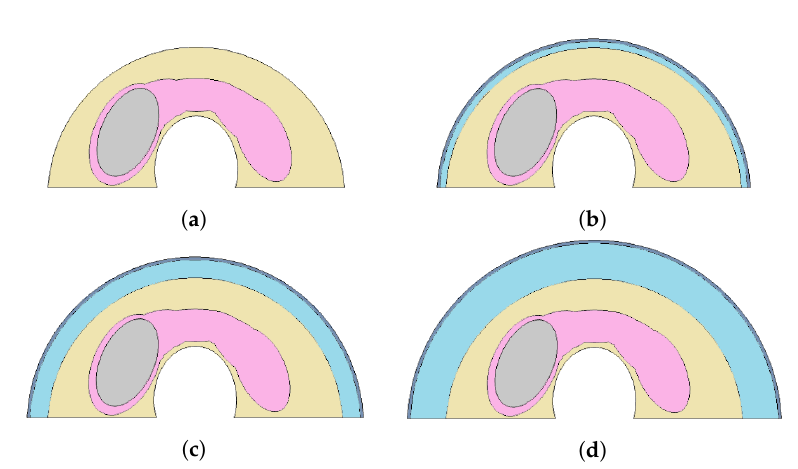
Figure 5. Fat tissue thickness used in the simulations: 0 cm ( a ), 0.3 cm ( b ), 0.6 cm ( c ), and 1.2 cm ( d